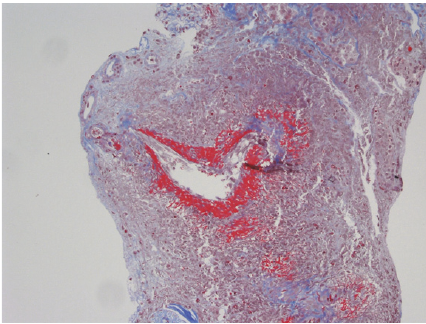
Figure 2: Full thickness fibrinoid necrosis of the vessels with surrounding interstitial necrosis.